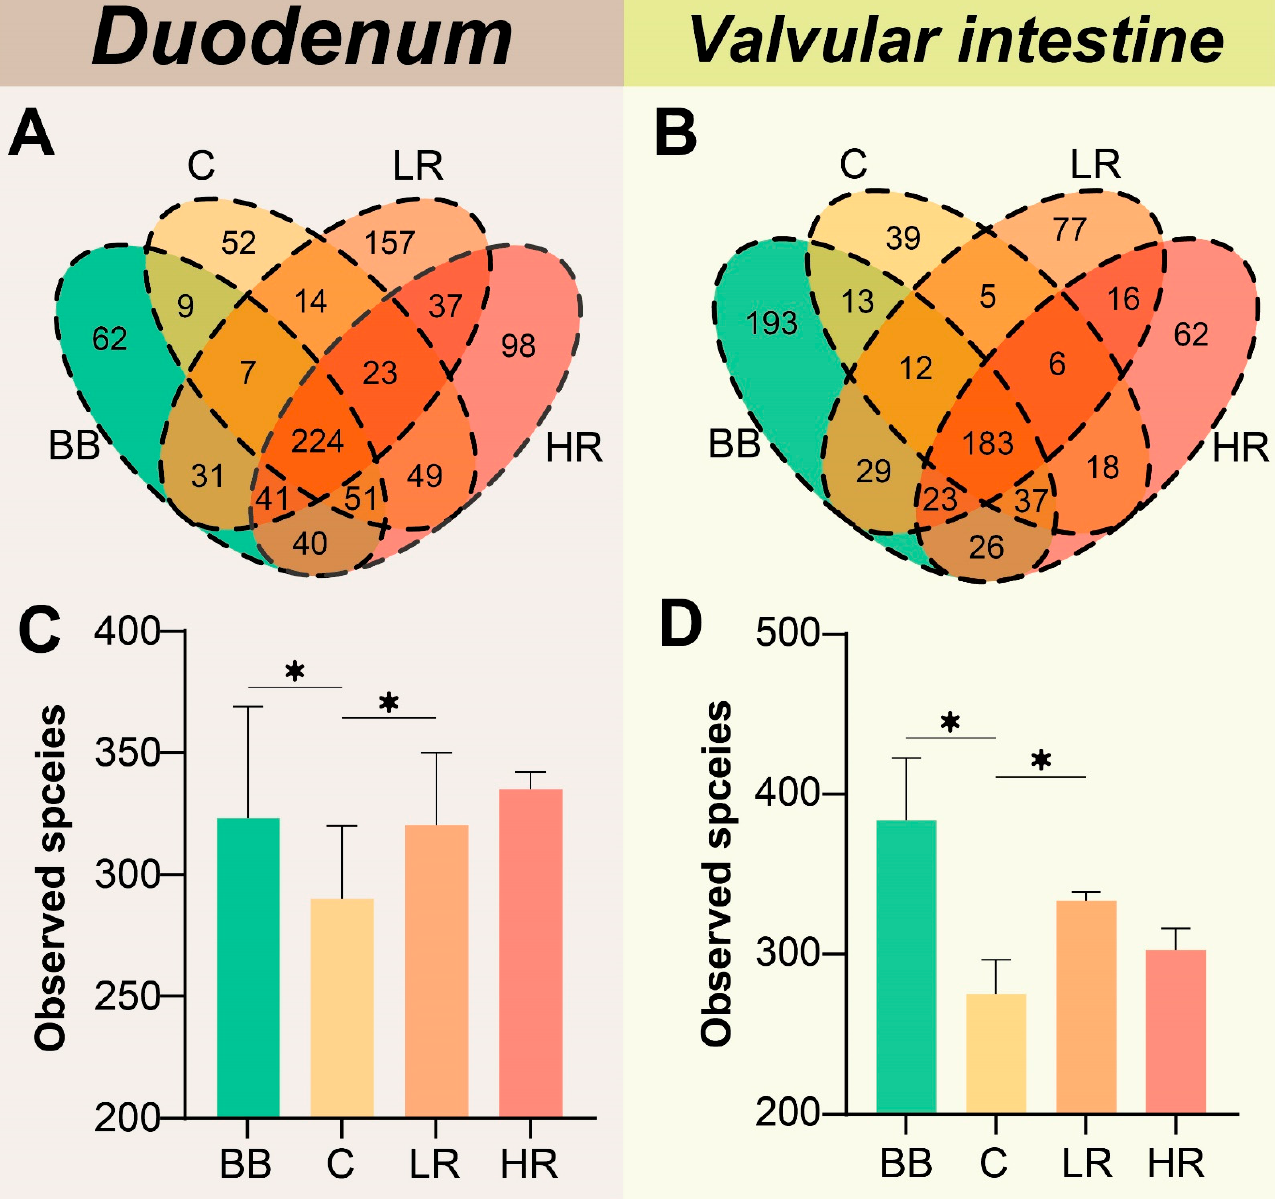
Figure 4. Community composition analysis among different groups. ( A , B ) Venn diagrams of OTU numbers in different groups. ( C , D ) Statistics of species number among different groups, * p < 0.05 vs. the control group; one-way ANOVA plus Bonferroni post-tests.